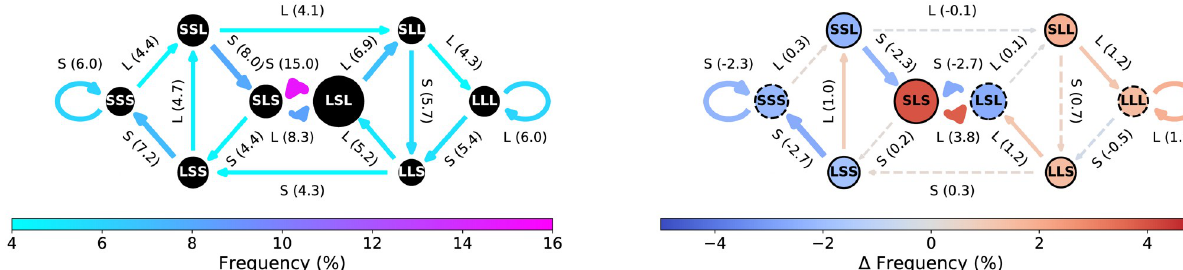
Fig 5. CODYMs by emotional content in PCCRI corpus. (Left) Normative patterns of patient turns for conversations where anger or fear are expressed. (Right) Difference CODYM, where Δ Frequency = (% Observed with anger or fear) − (% Observed without anger or fear). State and transition frequency distributions that are statistically significantly different ( P < 0.05 by Mann Whitney U tests) between patient turns in conversations with and without expressions of anger or fear are indicated in the difference CODYM by outlining states in black solid ( vs . dashed) circles and drawing transition arrows with solid ( vs . dashed) lines.